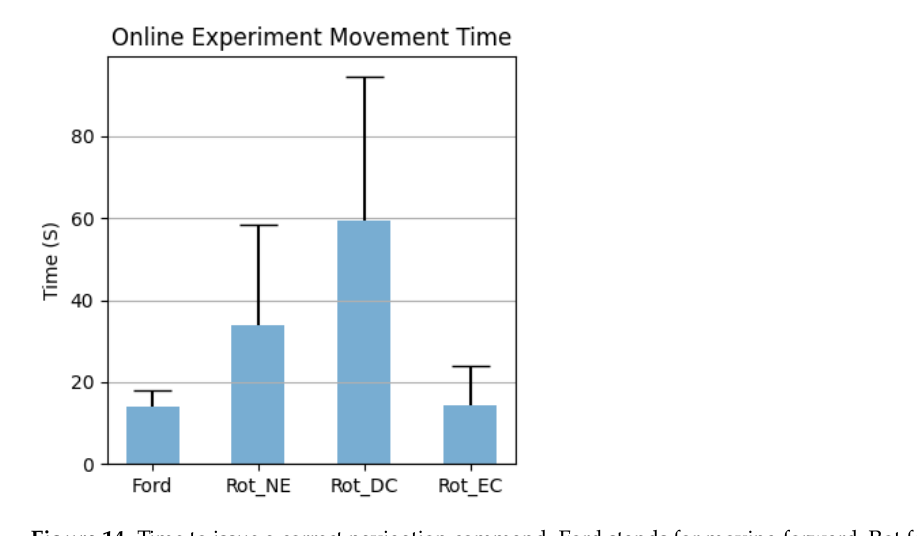
Figure 14. Time to issue a correct navigation command. Ford stands for moving forward, Rot for rotation, dc for double confirmation strategy, EC for error correction strategy, and NE for no error control strategy.